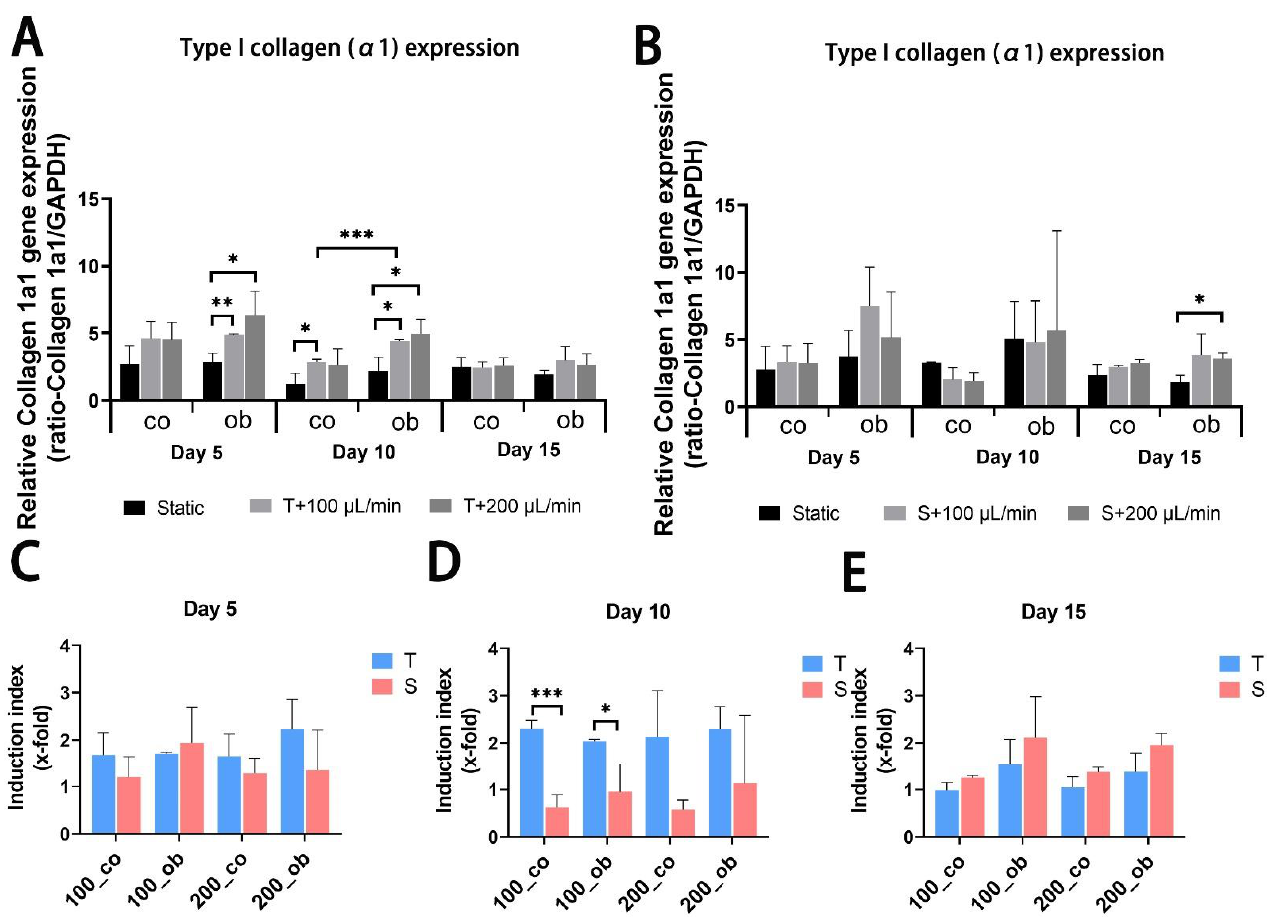
Figure 6. Gene expression levels of collagen 1 α 1 (COL1A1) in JPC-seeded β -TCP scaffolds after 5, 10 and 15 days of osteogenic differentiation under static or perfusion conditions. mRNA expression levels under ( A ) tangential and ( B ) sigmoidal configuration were quantified and normalized to the housekeeping gene GAPDH. To calculate induction indices, gene expression levels were normalized to untreated (co) or osteogenically induced (ob) JPCs under static condition. Induction indices of tangential (T) and sigmoidal (S) configuration after ( C ) 5 days, ( D ) 10 days and ( E ) 15 days of culture were calculated. The gene expression and induction values are given as means ± SD. Gene expression levels under different culture conditions (dynamic and static conditions) were compared using one-way ANOVA followed by Tukey’s multiple comparisons tests. For comparing levels of osteogenic condition to control and induction values between T and S, two-tailed Student’s t -test was used (* p < 0.05, ** p < 0.01, *** p < 0.001 (n = 3 donors)).